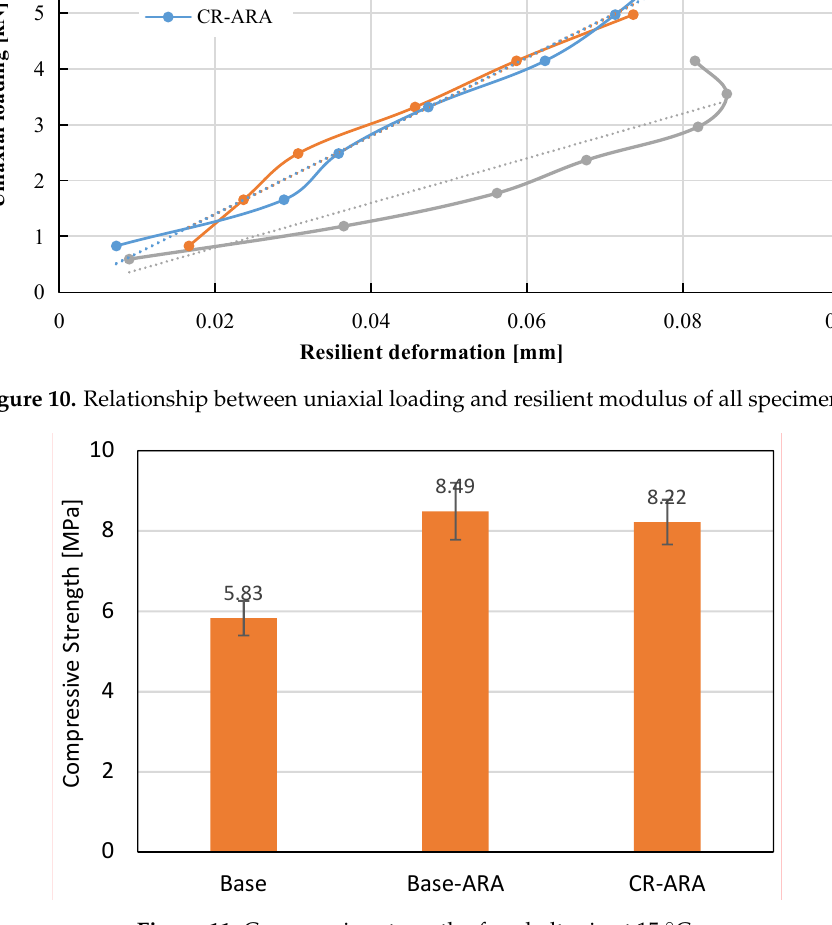
Figure 12. Resilient modulus of asphalt mix at 15 °C.